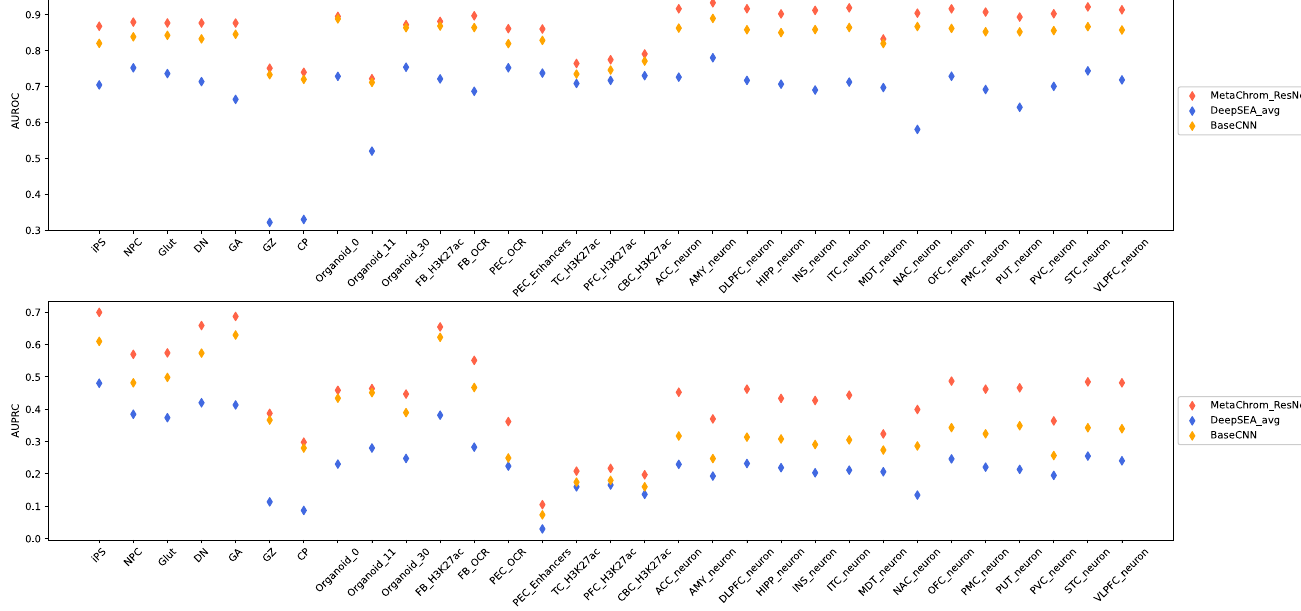
PLOS Computational Biology | https://doi.org/10.1371/journal.pcbi.1010011 May 16,